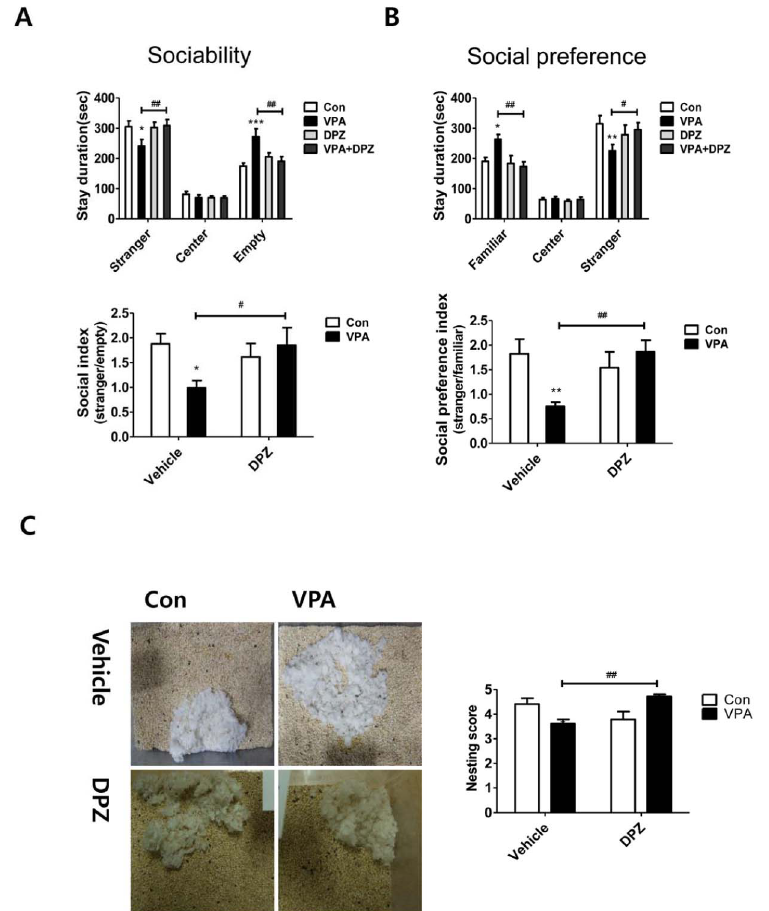
Figure 5. Subchronic treatment of donepezil improved social behavior in VPA exposed mice. In three chamber assay, sociability (A) and social preference (B) were measured. Upper panel showed stay duration (sec) in each compartment and lower panel showed social index and social preference index (N=10). (C) Nest building test. The built nests during 16 hours period were scored by trained experimenters who were blind to the experimental conditions (1, poor; 5, good), N=10. Data are expressed as the mean 6 S.E.M. *, **, ***, p , 0.05, p , 0.01, p , 0.001 vs. control in same compartment. # , ## , ### , p , 0.05, p , 0.01, p , 0.001 vs. VPA exposed mice in same compartment.